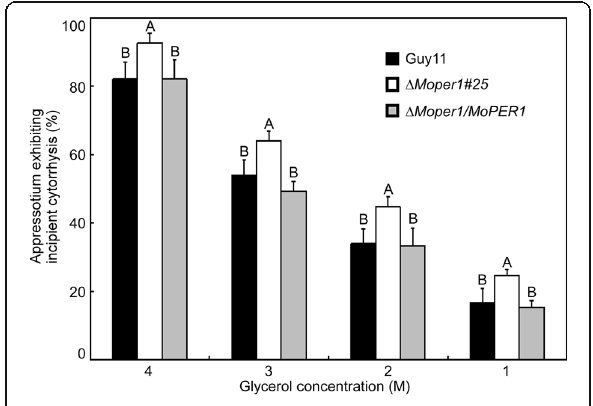
Fig. 7 Collapsed appressoria were observed in mutant strain. For each glycerol concentration, at least 100 appressoria were observed and the numbers of collapsed appressoria were